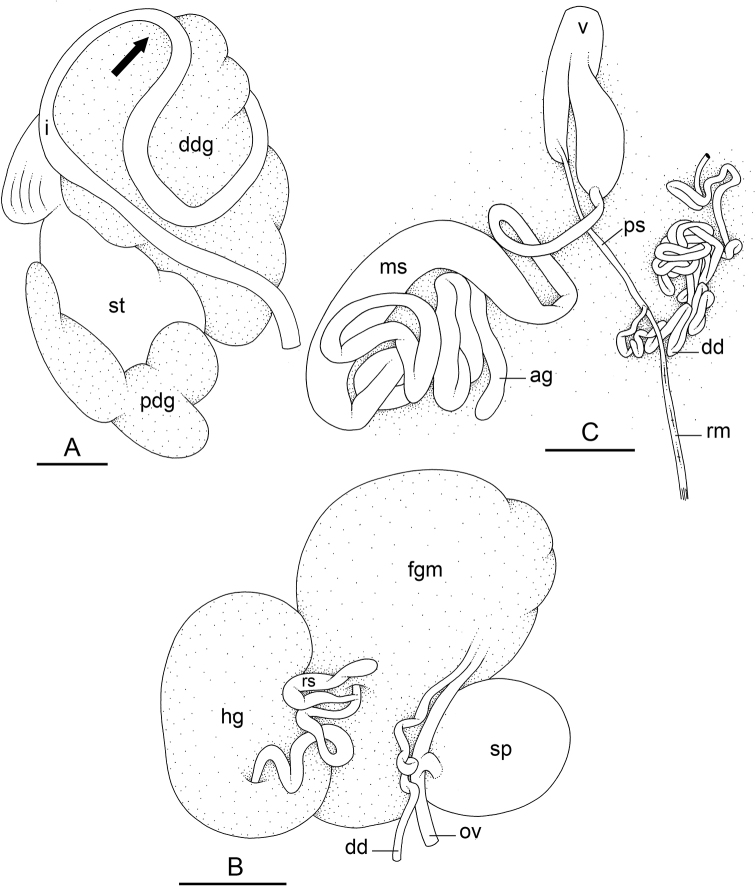
Peronia
okinawensis, Japan, Okinawa, holotype [696-4 H] (UF 352288) A digestive system, dorsal view, the arrow indicates the orientation of the transitional loop B posterior, hermaphroditic (female) reproductive system C anterior, male, copulatory apparatus. Scale bars: 3 mm (A–C). Abbreviations: ag accessory penial gland, dd deferent duct, ddg dorsal digestive gland, fgm female gland mass, hg hermaphroditic gland, i intestine, ms muscular sac, ov oviduct, pdg posterior digestive gland, ps penial sheath, rm retractor muscle, rs receptaculum seminis, sp spermatheca, st stomach, v vestibule.